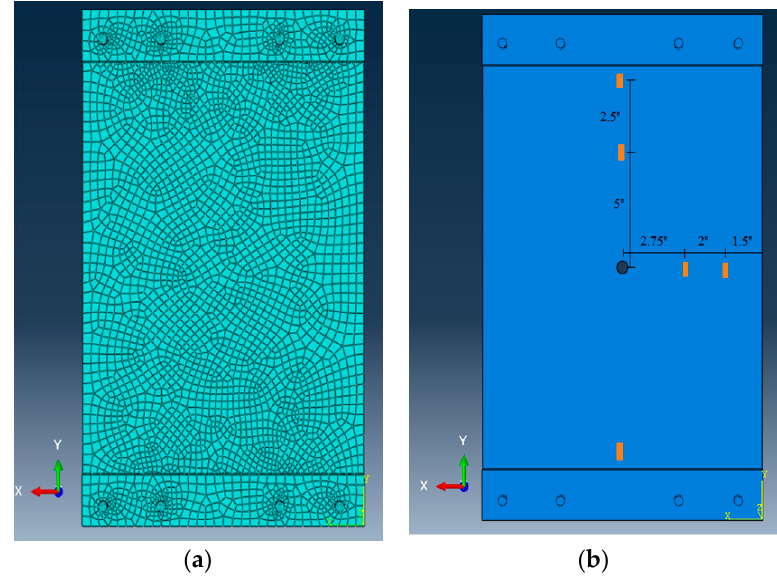
Figure 4. The FE analysis of the plate: ( a ) meshing and ( b ) sensing node locations.